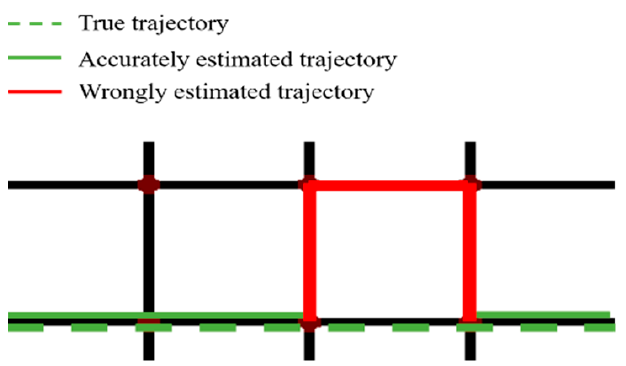
Figure 14. An illustration for the performance of trajectory estimation.